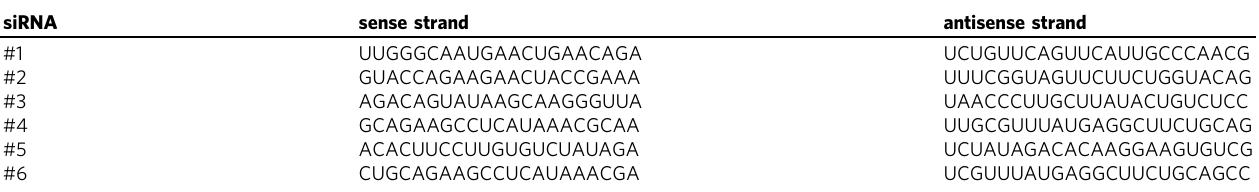
Table 2 Mouse Angptl7 siRNA sequences used to knockdown mAngptl7.